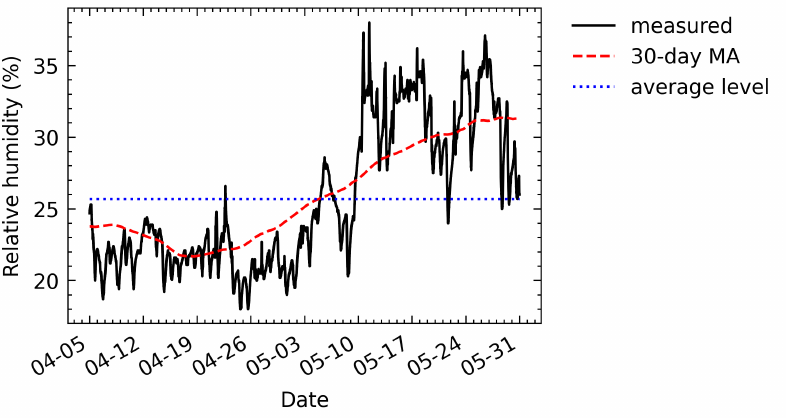
Figure 14. Relative humidity readings measured during eight weeks and a monthly relative humidity cycle obtained by calculating the 30-day central moving average (MA) of the readings. According to the obtained monthly cycle, the fluctuation of each sampling point for the monthly cycle was calculated. After sorting these fluctuations in ascending order, the obtained 7th percentile value was − 4.0% while the 93rd percentile value was 4.2% (see Figure 15). The absolute values of the 7th and the 93rd percentiles are both less than 10%. Therefore, according to the standard, the allowable fluctuation range can be relaxed to